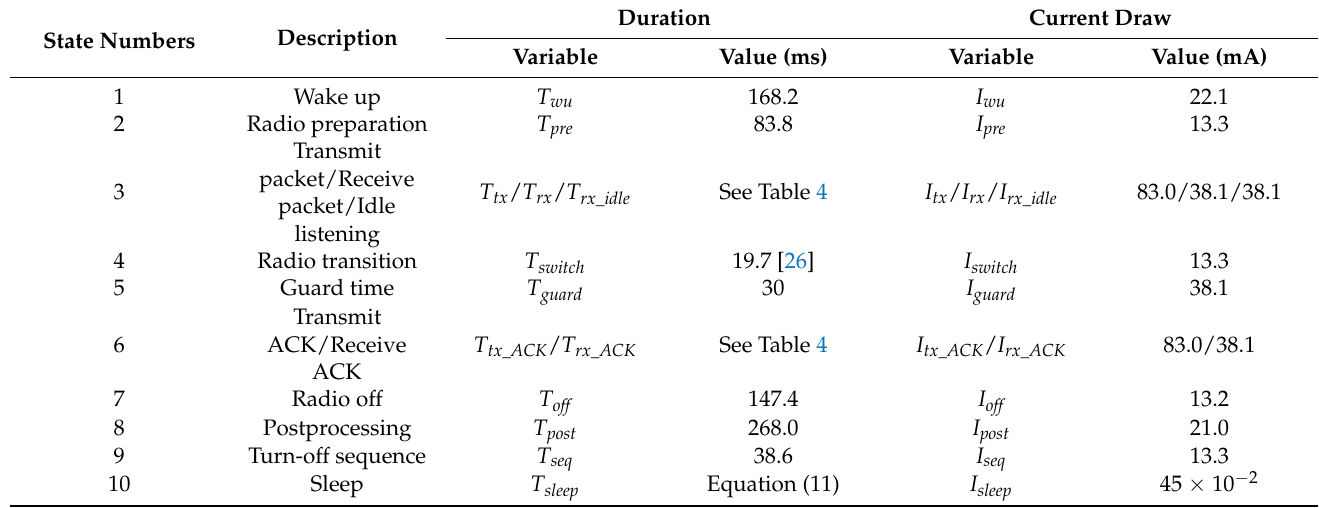
Table 3. States and associated variables, together with their values for the communication process [24].